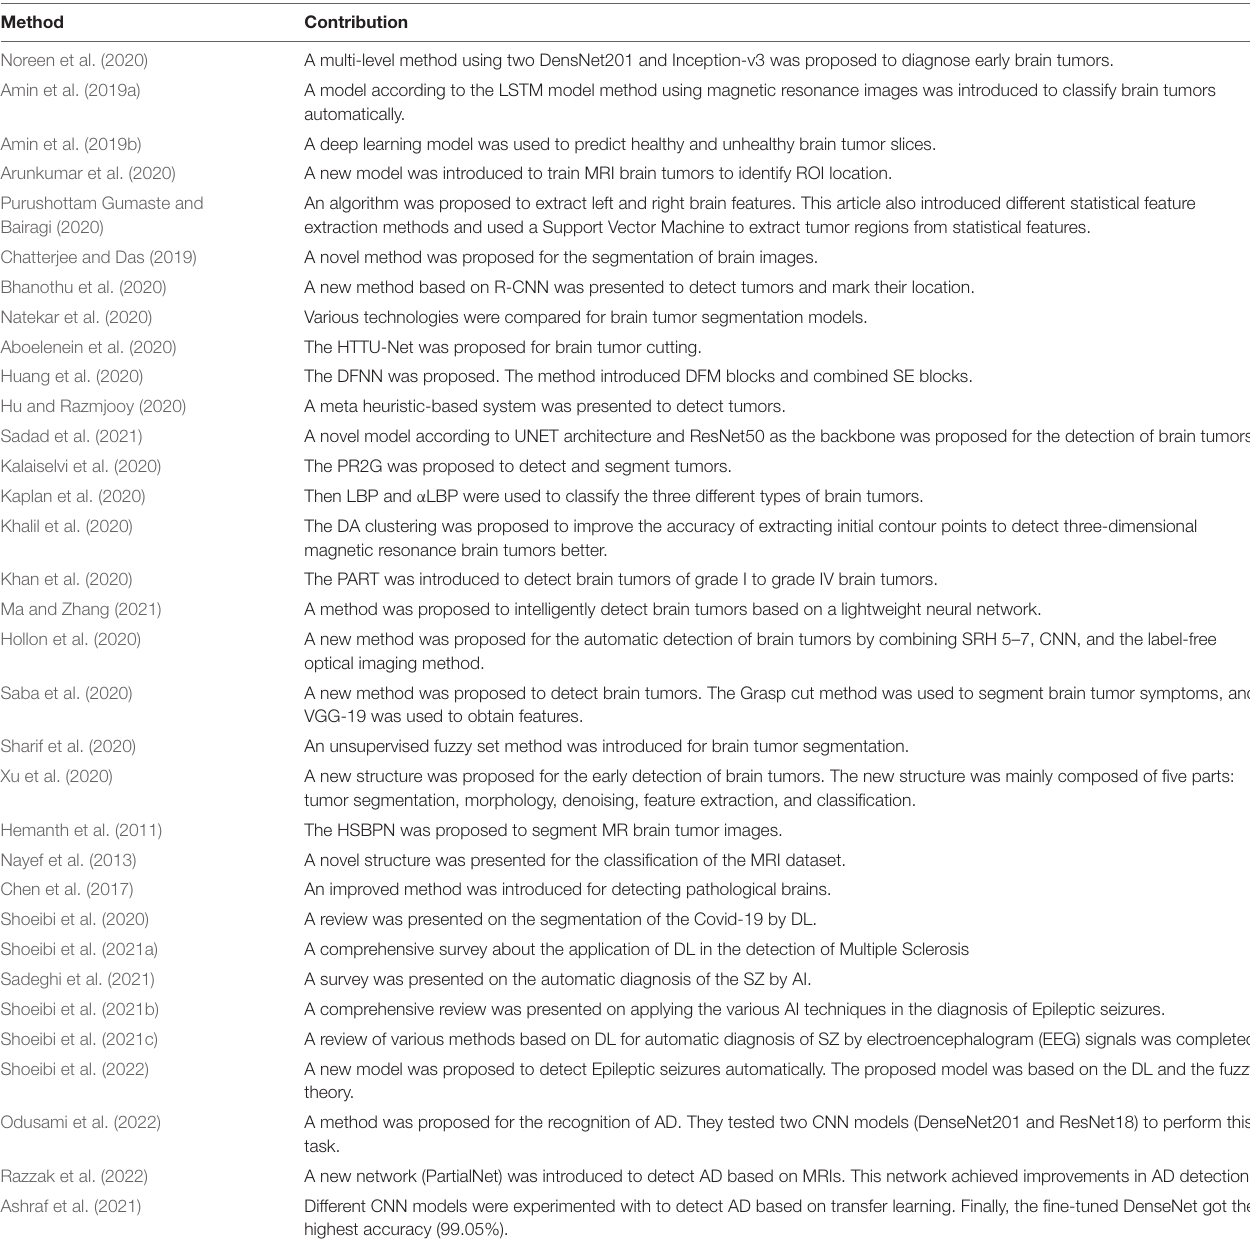
TABLE 1 | Contributions of state-of-the-art methods. Method